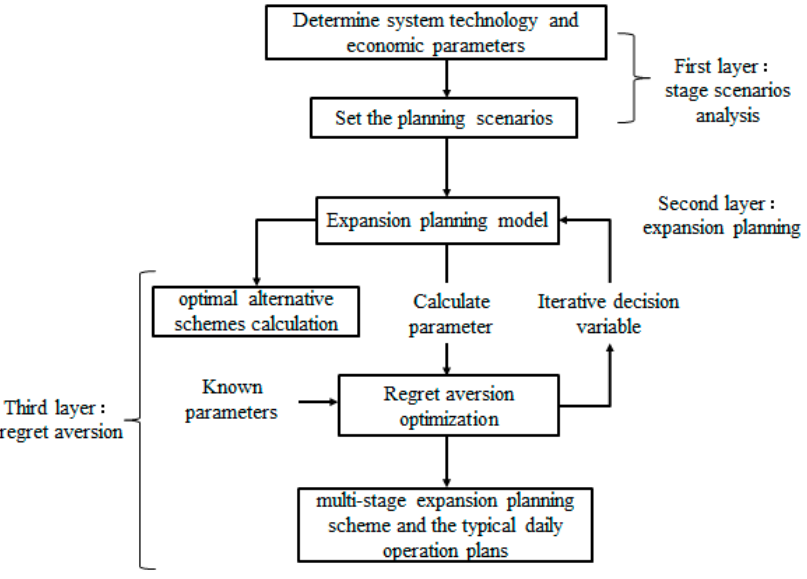
Figure 2. Expansion planning method of IPIES considering regret